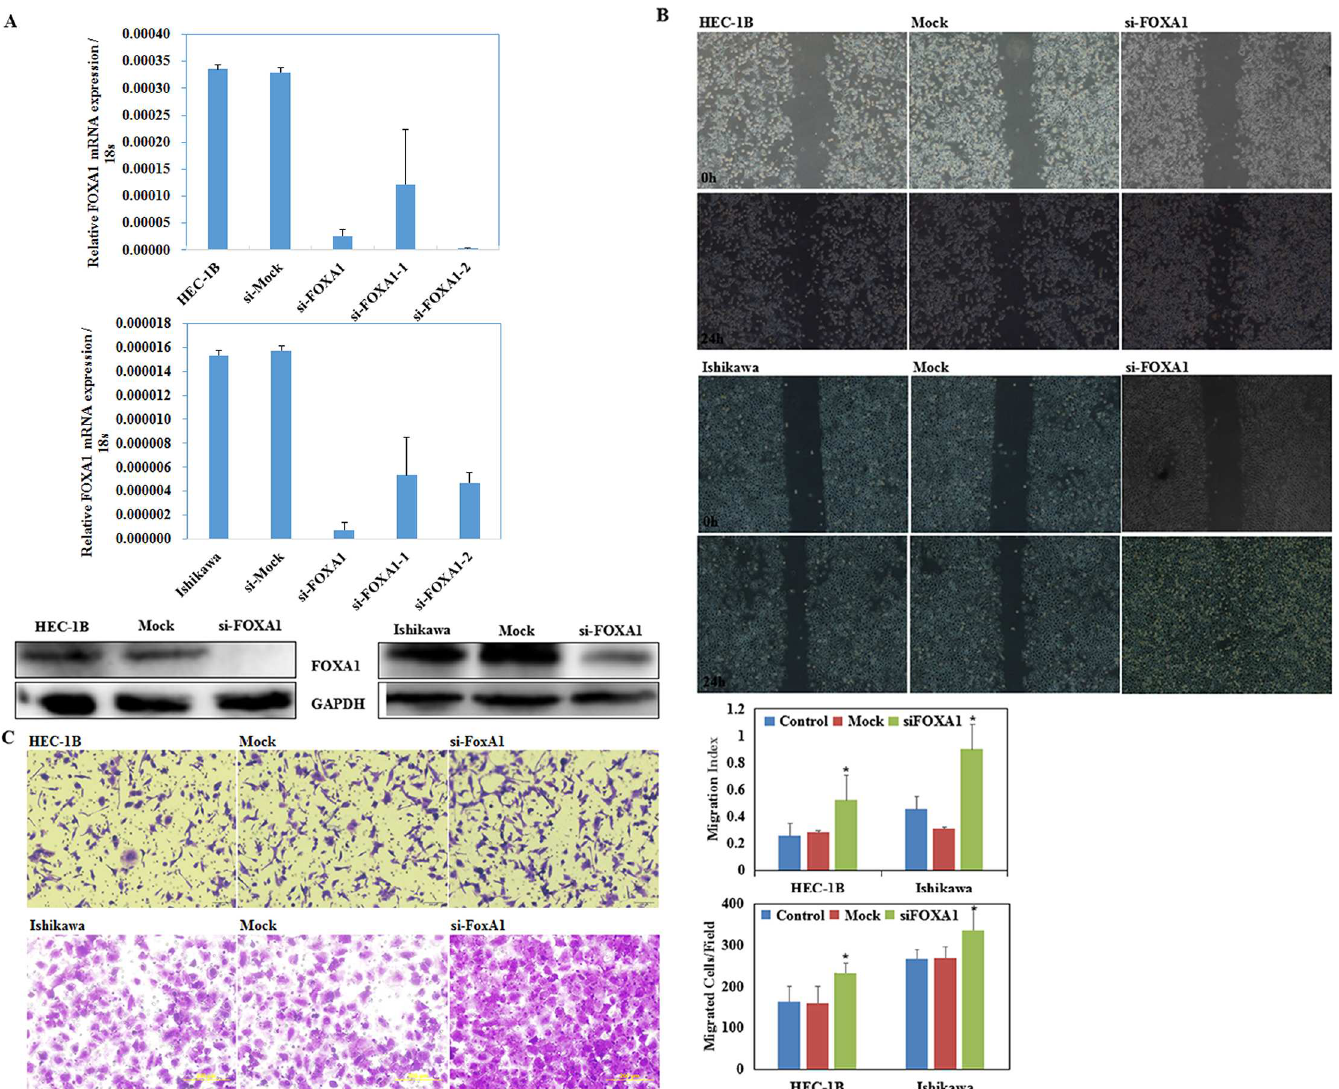
Fig 5. siFOXA1 transfection promoted endometrial carcinoma cell migration and invasion. After siFOXA1 transfection, the expressionlevels of FOXA1 decreased significantly (A). Endometrialcarcinomacell lines exhibitedfaster migration (B) , and stronger invasion (C) comparedwith the control and mock cells 24 hours after transfection. Three representative microscopicfields of each well (n = 3) were documentedto quantify the extent of invasionand migration,and three independentexperiments were performed.Data are expressedas the mean ± standard deviation, * P <